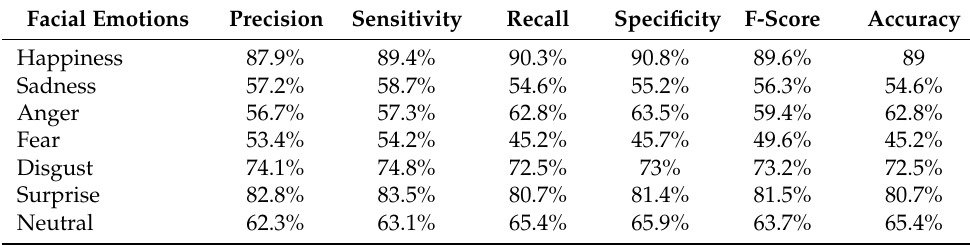
Table 5. The results of evaluation metrics for the proposed method on the AffectNet dataset. Facial